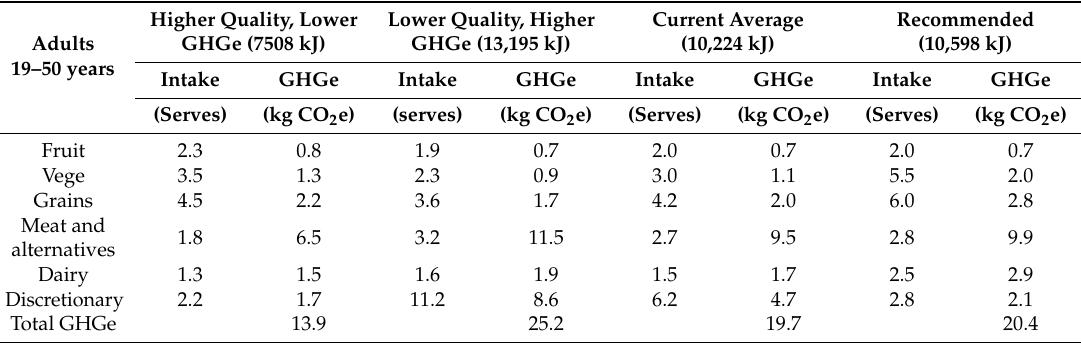
Table 3. The average food intake (in serves) and dietary emissions from the three current dietary pattern scenarios and the recommended dietary pattern, for adults aged 19–50 years *.